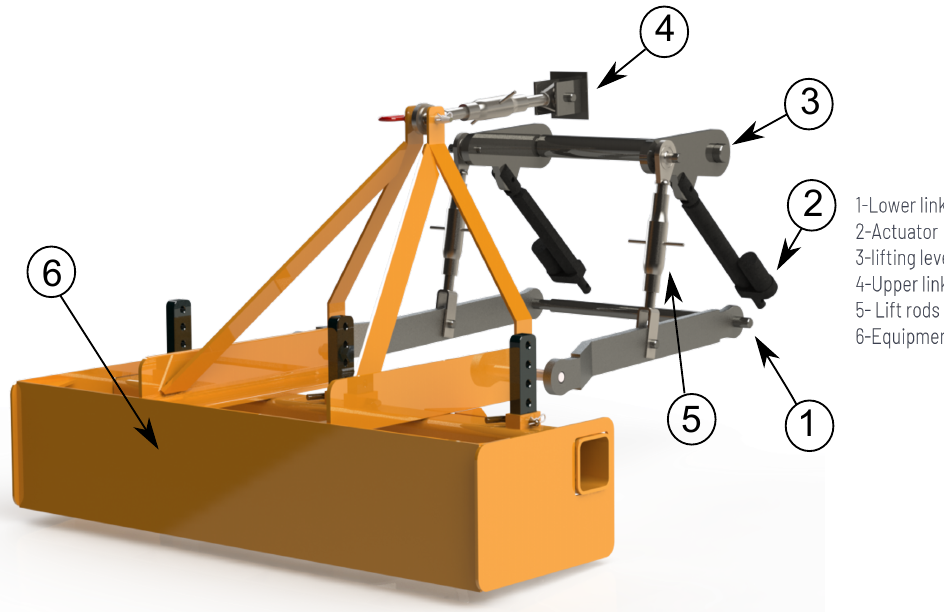
Figure 3. A 3D Model of the equipment attached to the three-point hitch, designed in the Solidworks